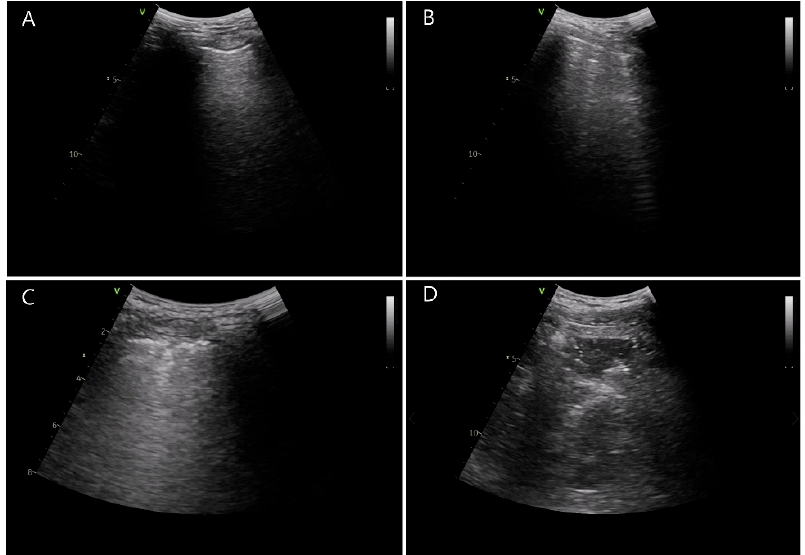
Figure 2. Lung ultrasound scores determined by the number of B lines and subpleural consolida- tion. ( A ) Normal aeration with 0–2 B lines, score = 0, ( B ) a small loss of aeration with ≥ 3 B lines, score = 1, ( C ) a moderate loss of aeration with multiple coalescent B lines or small subpleural con- solidation, score = 2, and ( D ) a severe loss of aeration with consolidation or large subpleural con- solidation, score = 3.